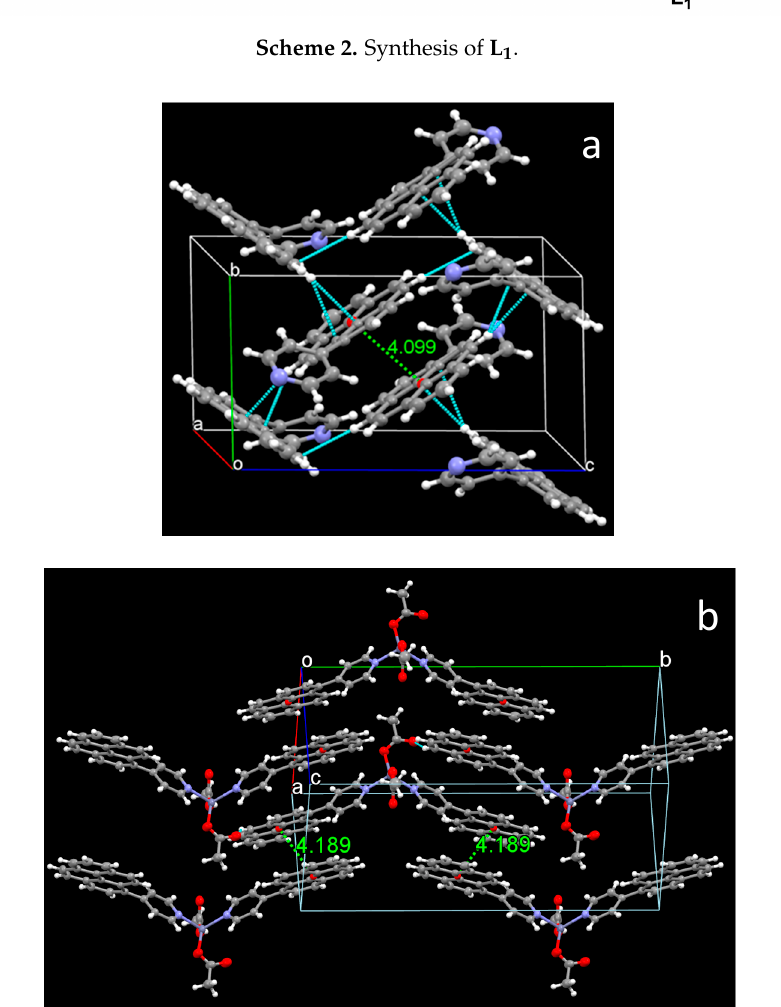
Figure 1. Fragments of the crystal packing of ( a ) L 1 (viewed approximately along the a direction) and ( b ) ZnL 1 (viewed approximately along the ac direction) showing hydrogen bonds (light blue dashed lines) and distance between centroids of the pyrene units (green dashed line). Ellipsoids drawn at 30% probability.